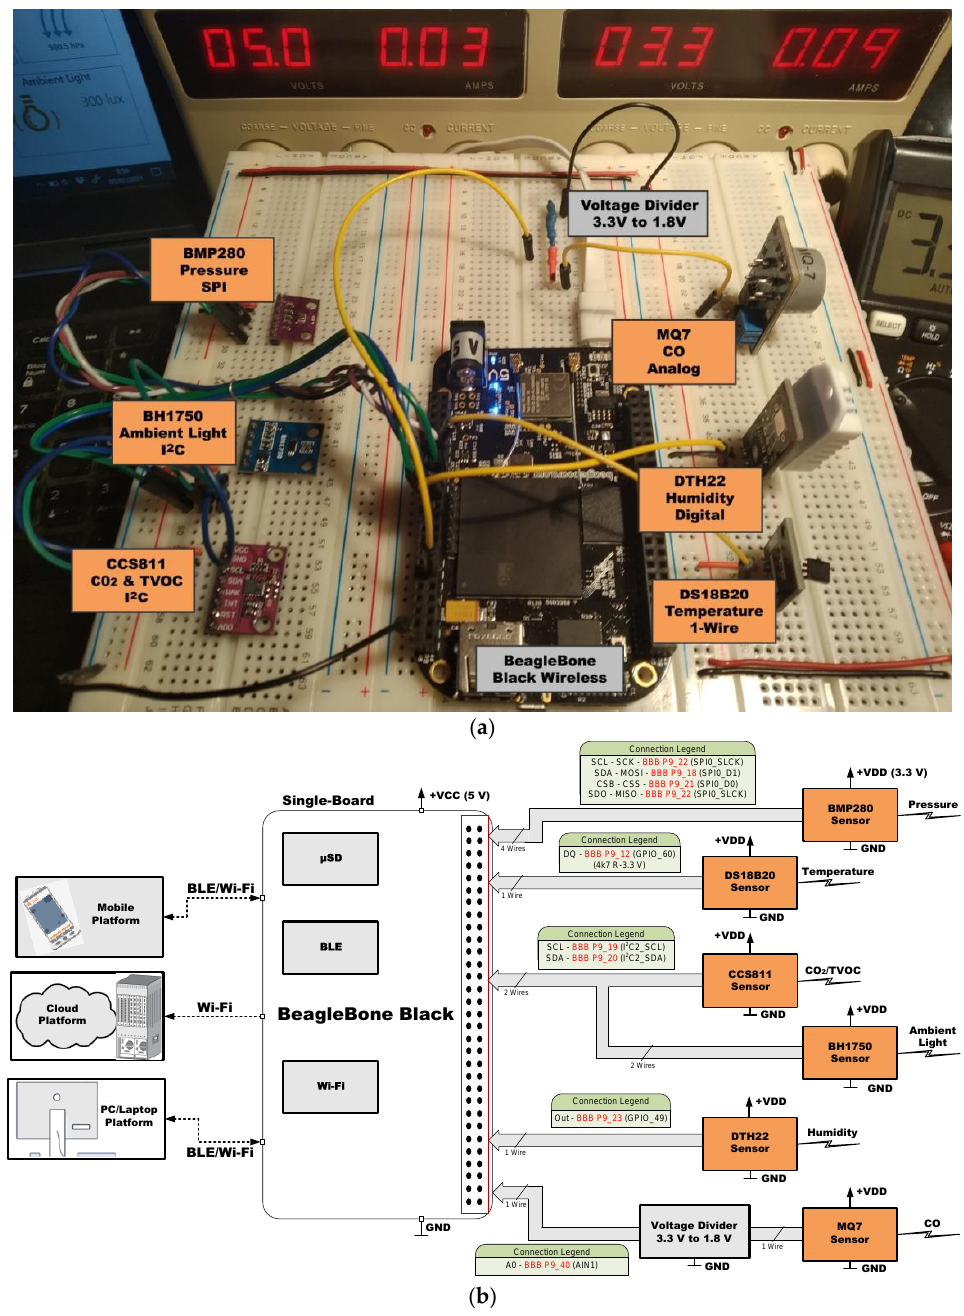
Figure 6. SBC BeagleBone Black in experimental framework ( a ) and hardware connections ( b ) [150].